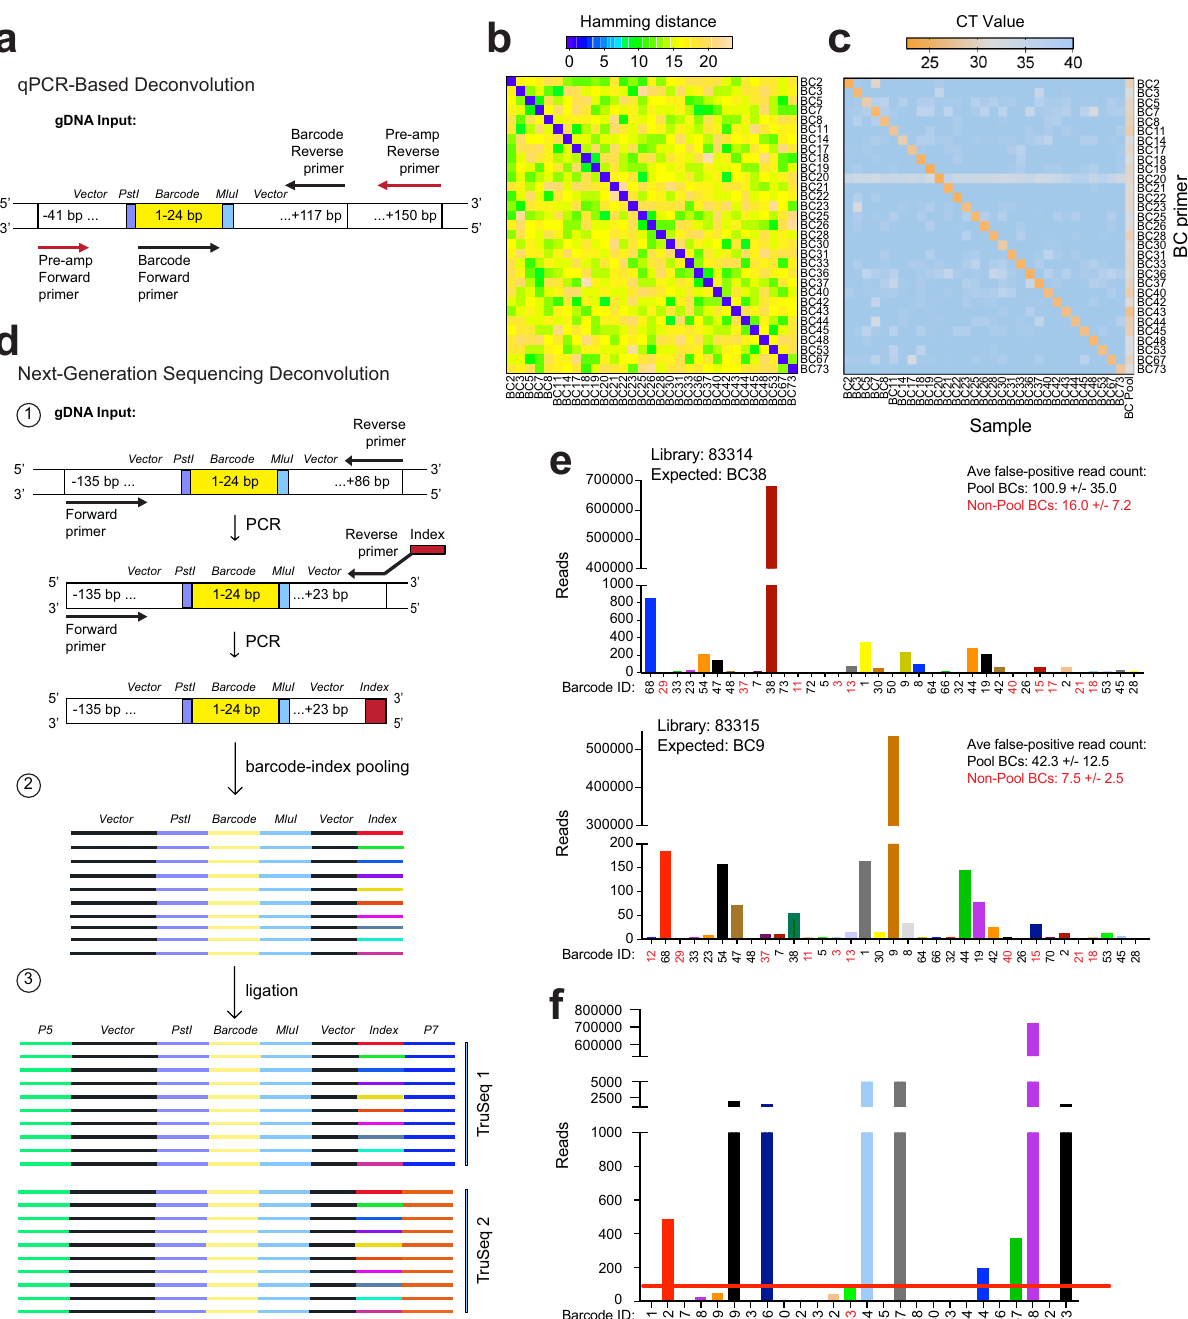
Fig. 2 BC Detection by qPCR and next generation sequencing methods. a qPCR-based BC identi fi cation and quanti fi cation is achieved by subjecting sample gDNA to 2 rounds of PCR using pre-ampli fi cation primers (red, round 1) and BC-speci fi c primers (black, round 2). b Heatmap showing hamming distance between all barcodes in the Met1 BC Pool. c Heatmap of qPCR cycle threshold (CT) values after testing each indicated barcode oligonucleotide primer against every Met1 BC population and the Met1-BC pool. d Multiplexing of gDNA samples for NGS is achieved in 3 steps. 1: Barcode regions in each gDNA sample are PCR-ampli fi ed using primers to universal barcode fl anking sequences. To the resulting amplicons from each sample, one of 20 available unique 8-bp indexes is added downstream (3' end) of the barcode region via PCR. 2: Up to 20 different indexed amplicons (various colors) are pooled to generate a single barcode-index library. 3: Amplicons in each barcode-index library are ligated to Illumina adaptors. A universal P5 adaptor (green) is ligated upstream (5' end) and one of 24 available P7 adaptors (e.g., TruSeq1, blue and Truseq2, orange) is ligated downstream (3' end) of the barcode region. e Sequencing read counts from 2 HMLER-HR BC test samples. Each library corresponds to a single Illumina adaptor, and the expected barcode pair for each library is indicated. For each library, the average false-positive read count (±S.E.M.) per BC is shown for BCs in the HMLER-HR BC Pool (black) and for BCs not represented in the HMLER-HR BC Pool (red). All BCs that yielded a read count are represented. f Example of thresholding method for identifying BCs from experimental samples by NGS. Graph shows read counts for each barcode from an HMLER-HR BC Pool tumor. The only false positive read corresponds to BC43, which was used to set the false-positive threshold (red line). Barcodes with read counts below the threshold were discarded as sequencer noise. Source data are provided as a Source Data fi